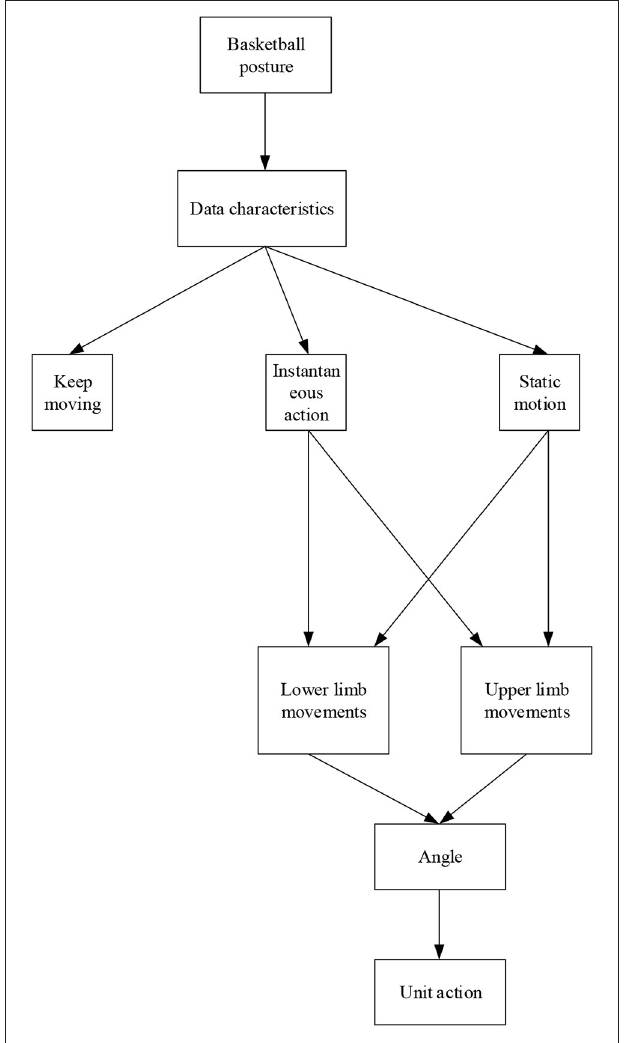
FIGURE 3 | Data division method of basketball posture.